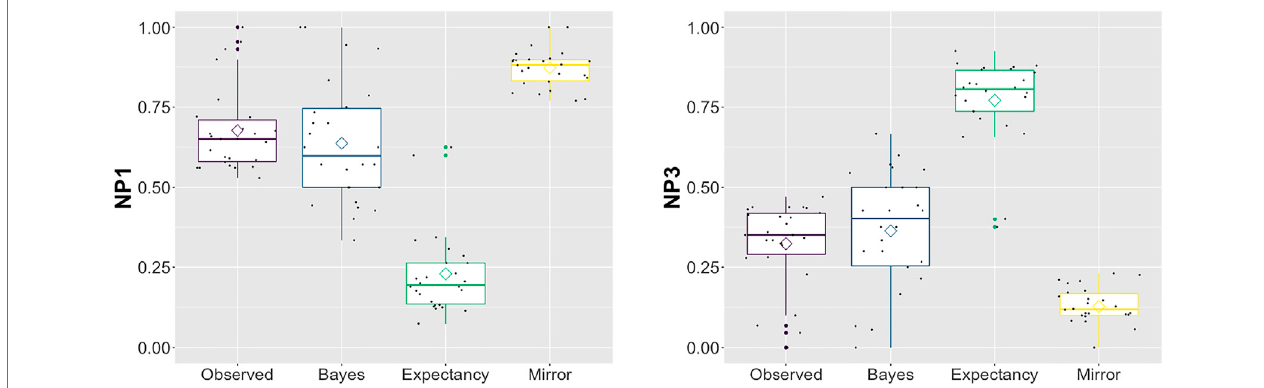
FIGURE 2 | By-item observed values and model estimates for each referent in Experiment 2. Tilted squares indicate the means.